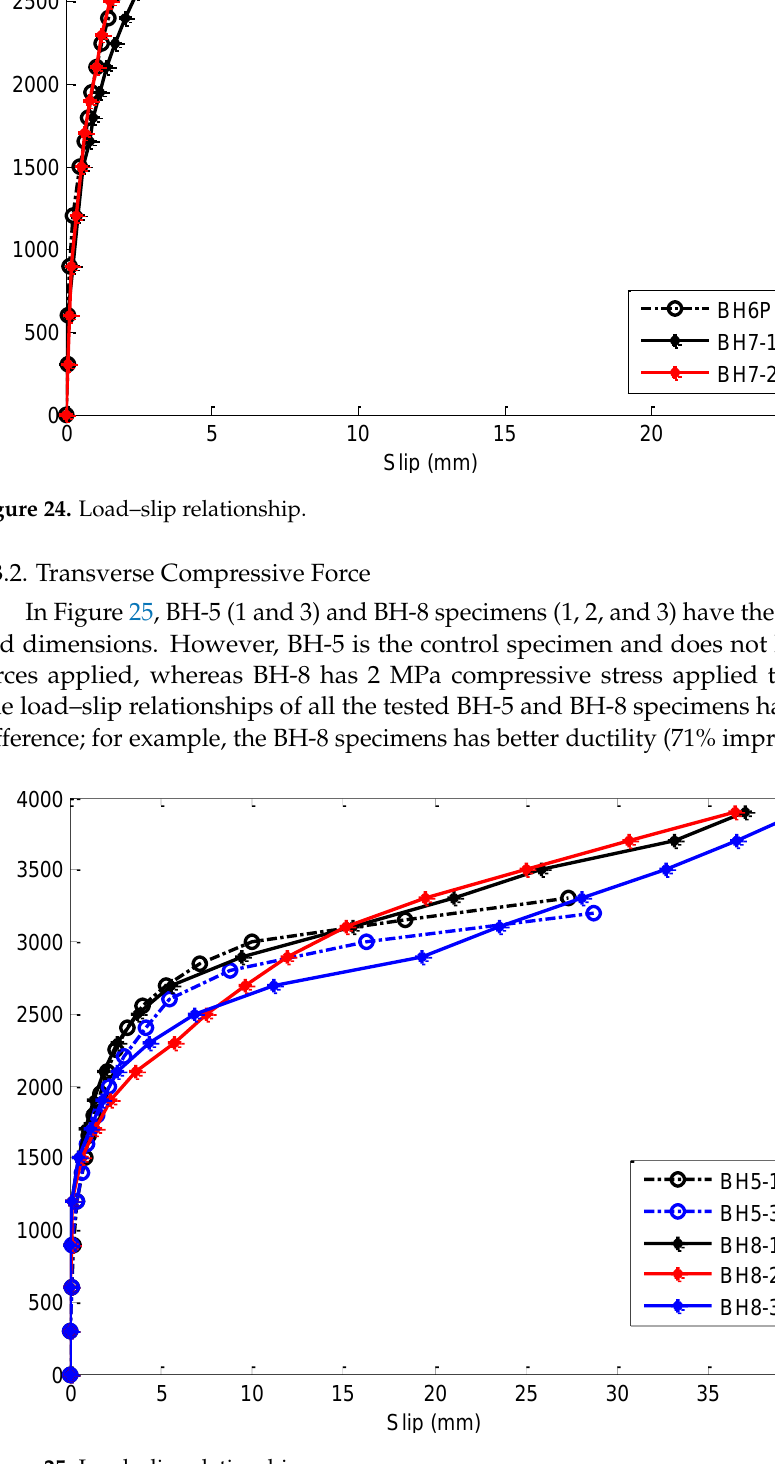
( b ) Figure 26. Concrete dowel failures of the BH3 specimen after the test: ( a ) Concrete dowel failures of the BH3-1 specimen; ( b ) Concrete dowel failures of the BH3-2 specimen.